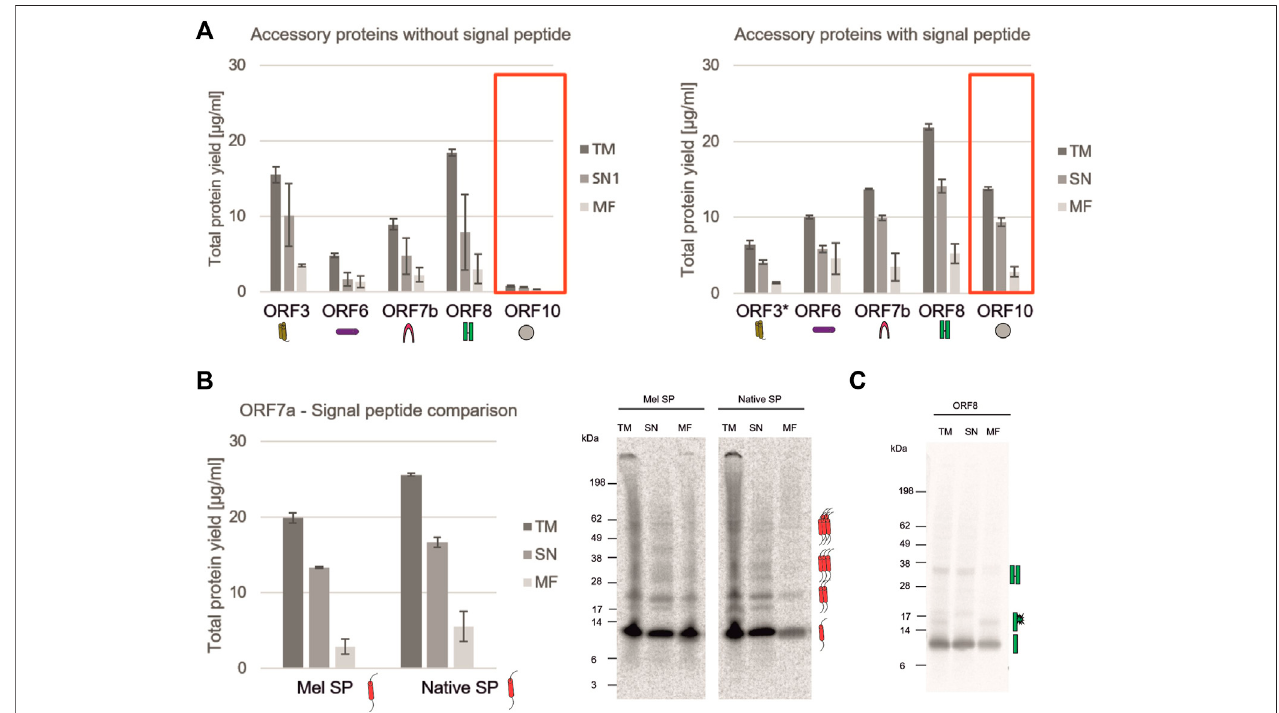
FIGURE 4 | Analysis of SARS-CoV-2 accessory proteins. (A) Accessory proteins ORF3, ORF6, ORF7b, ORF8 and ORF10 with and without a Mel signal peptide were synthesized in a CHO batch-based reaction. Quantitative analysis of cell-free synthesized proteins was performed by liquid scintillation counting. Standard deviations were calculated from triplicate analysis. The template for ORF3 with a Mel signal peptide was based on a PCR-template (*). (B) ORF7a was synthesized in a CHO batch-based cell-free system with Mel and a native signal peptide. Quantitative analysis of cell-free synthesized proteins as performed by liquid scintillation counting. Standarddeviationswerecalculatedfromtriplicateanalysis.Qualitativeanalysisbyautoradiography. (C) AutoradiographshowingORF8synthesizedinaCHO cell-free system. In all experiments, the translation mixture (TM) was separated into the soluble proteins in the supernatant (SN) and the microsomal fraction